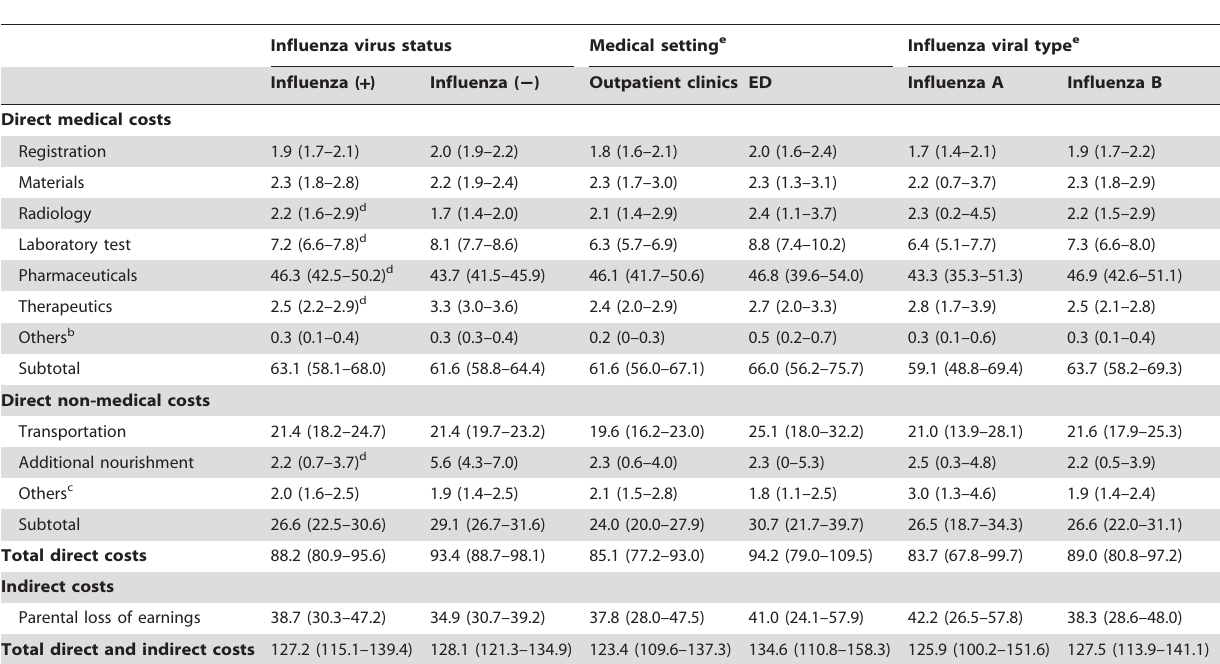
Table 3. Direct and indirect costs per episode of influenza-like illness (ILI) for influenza positive and negative cases, by medical setting and viral type among influenza positive cases, mean U.S. dollars (95%CI) a